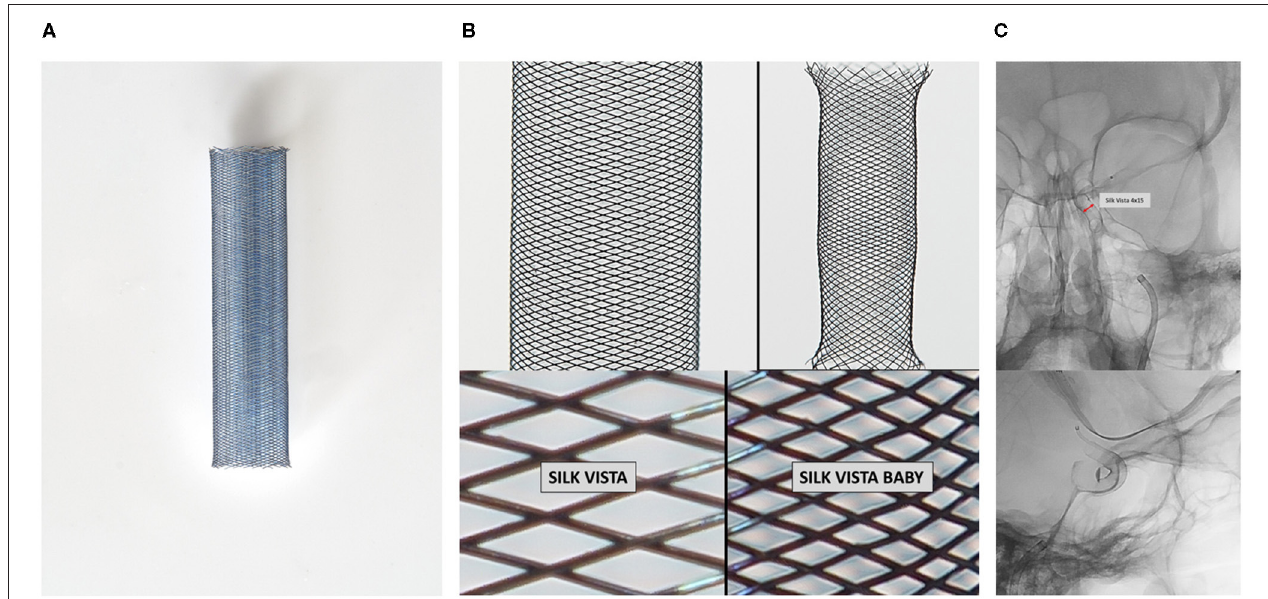
FIGURE 1 | Schematic graphic representation of the SV delivery system. (A) SV appearance fully open; (B) comparison between SV and SVB, both with 48 DFT. The SV, however, are three times less dense and no present flared ends. (C) Good radiopacity SV. SV, Silk Vista; SVB, Solk Vista Baby.